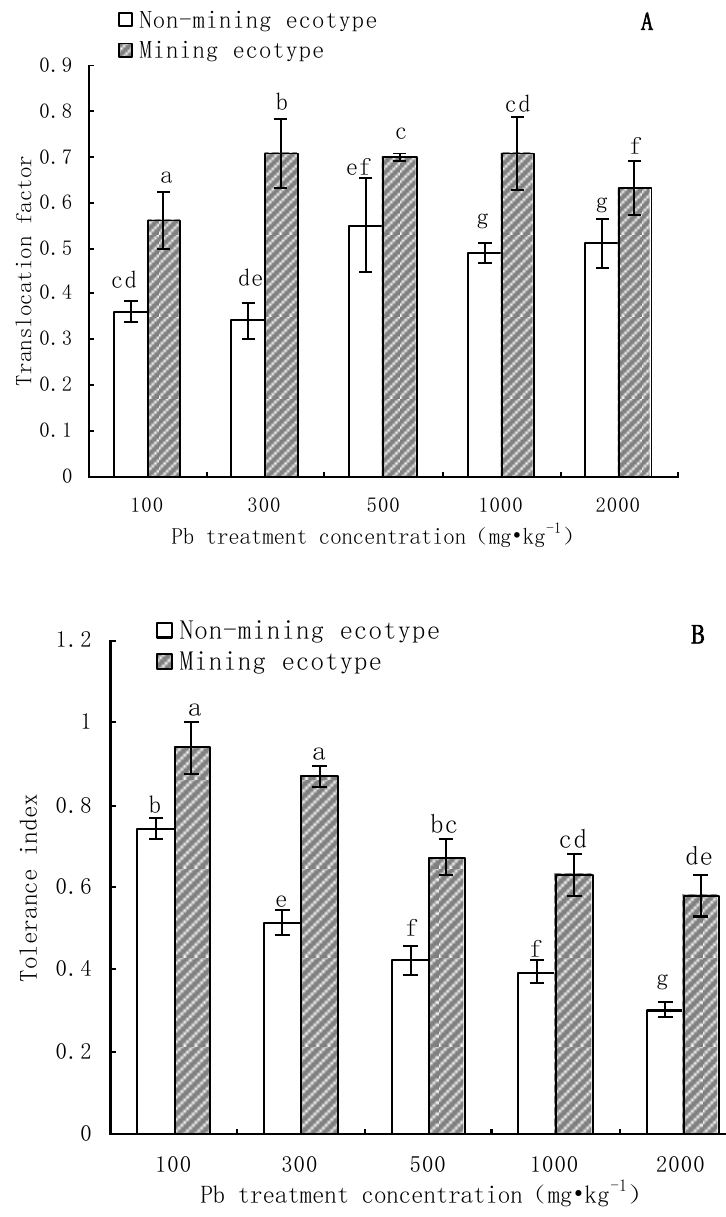
Figure 5. Translocation factor and tolerance of Two ecotypes of M. floridulus under different Pb treatment (( A ) is TF , ( B ) is TI ). Note: Error bars indicate standard deviation; different letters in the same group indicate significant difference at p < 0. 05 according to Duncan’s multiple range tests. The larger the tolerance index, the stronger the tolerance to Pb. As can be seen from the figure, under mild Pb stress (100 mg · kg − 1 , 300 mg · kg − 1 ), the tolerance index of non-mining ecotypes of M. floridulus decreased significantly ( p < 0.05), while the tolerance index of mining ecotypes of M. floridulus did not decrease significantly ( p > 0.05).